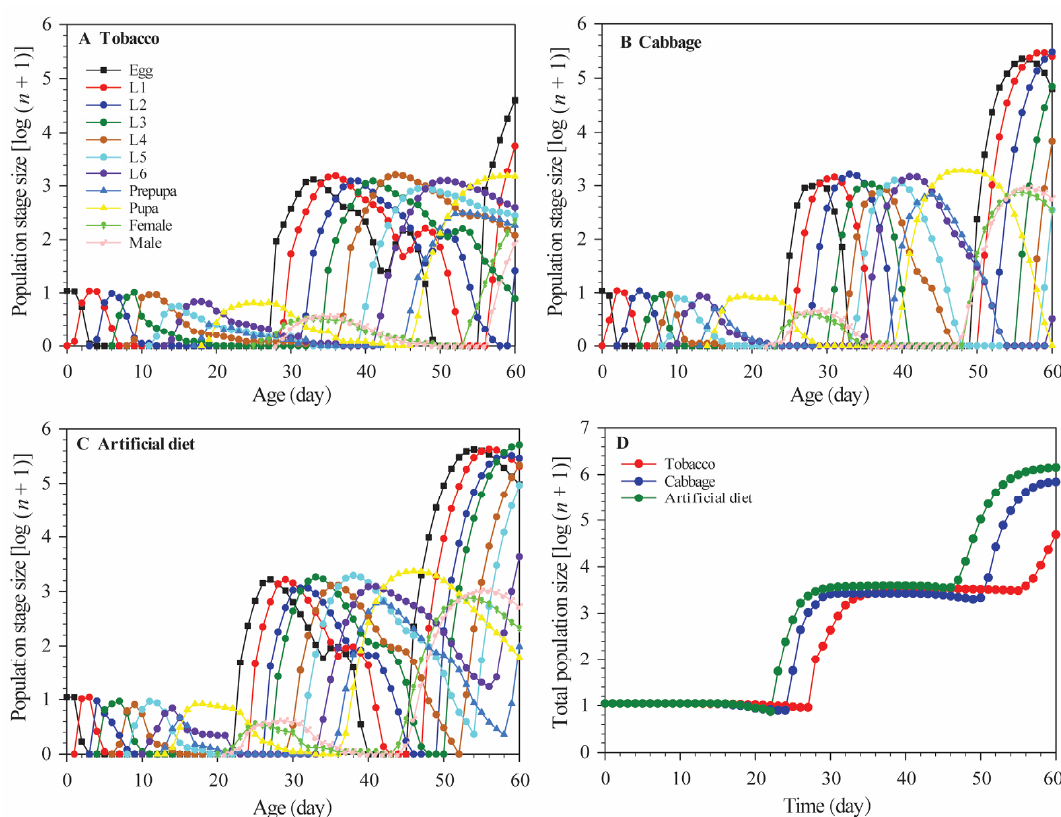
Figure 5. Population projections of Spodoptera litura in different stages fed ( A ) Chinese cabbage; ( B ) tobacco; ( C ) artificial diet; ( D ) represents the mean for the overall population of each diet group.